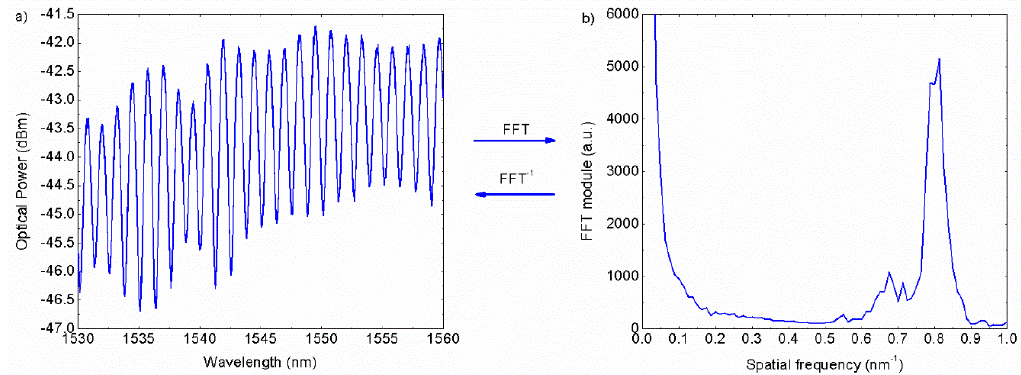
Figure 1. ( a ) Optical microstructured optical fiber-Fabry–Pérot (MOF-FP) sensor´s spectral transfer function and ( b ) its Fast Fourier Transform (FFT) module.